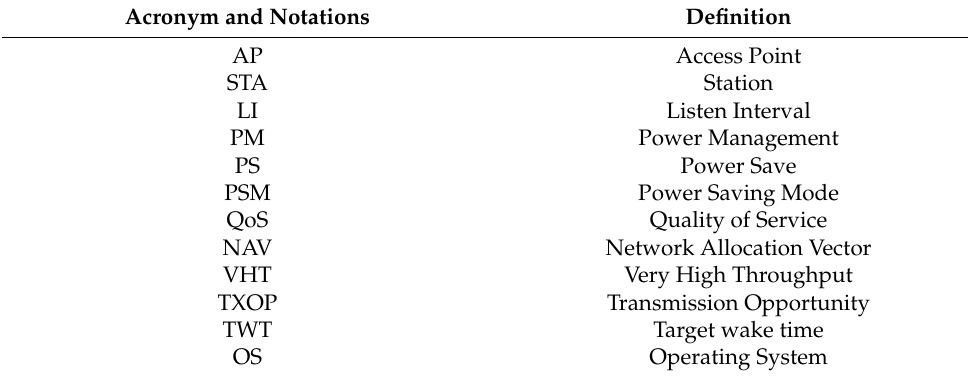
Table 1. Acronyms and